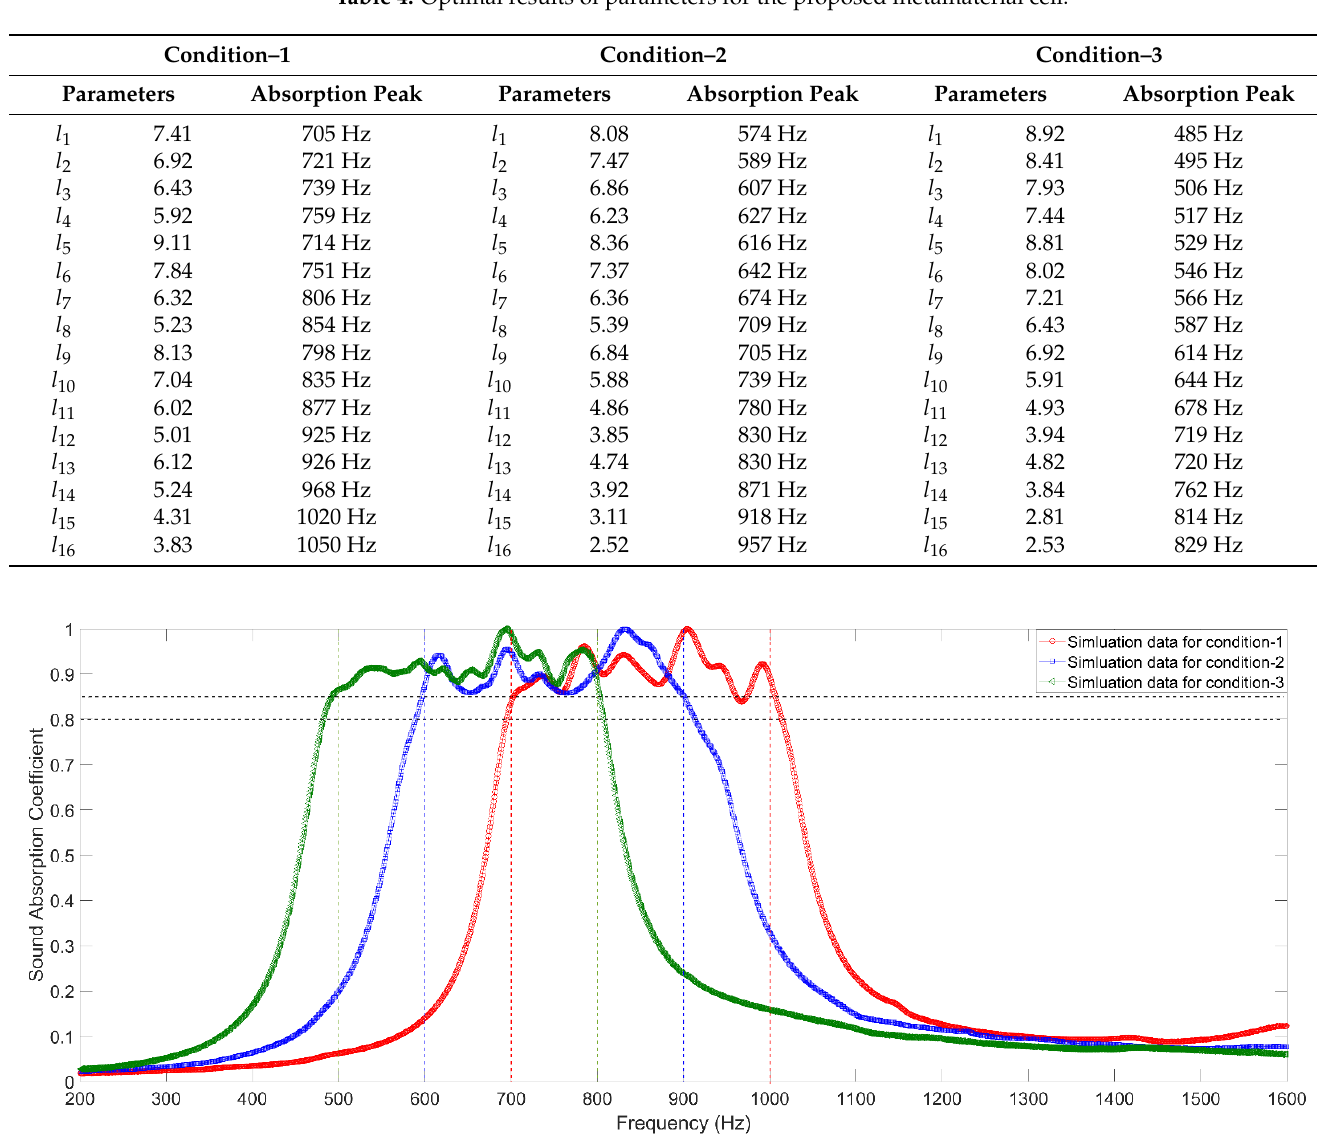
Table 4. Optimal results of parameters for the proposed metamaterial cell.